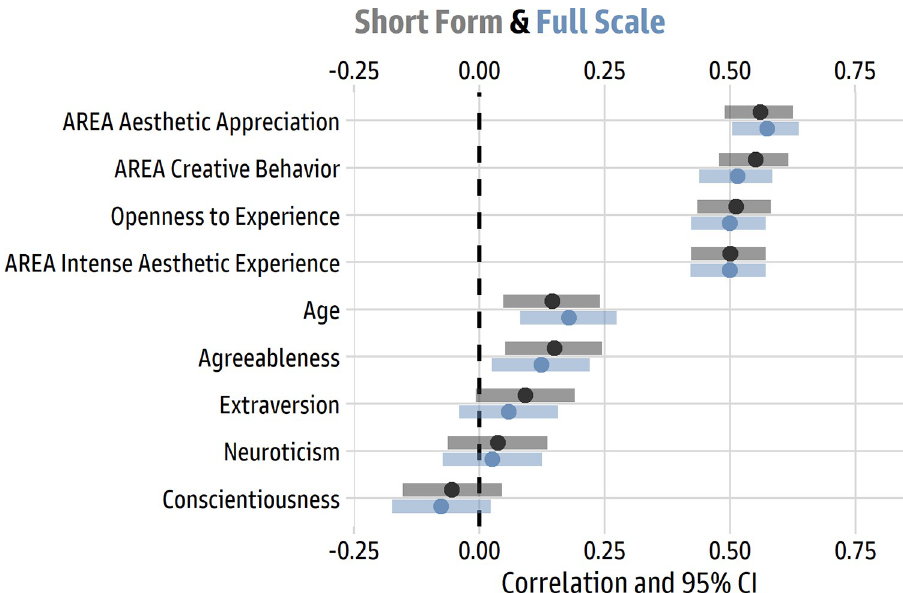
Fig 10. Pearson correlations for the short form and full scale. The dots represent the Pearson r correlation value; the bars represent the 95% confidence interval around r . The 10-item short form is illustrated in grey; the 26-item long form is illustrated in